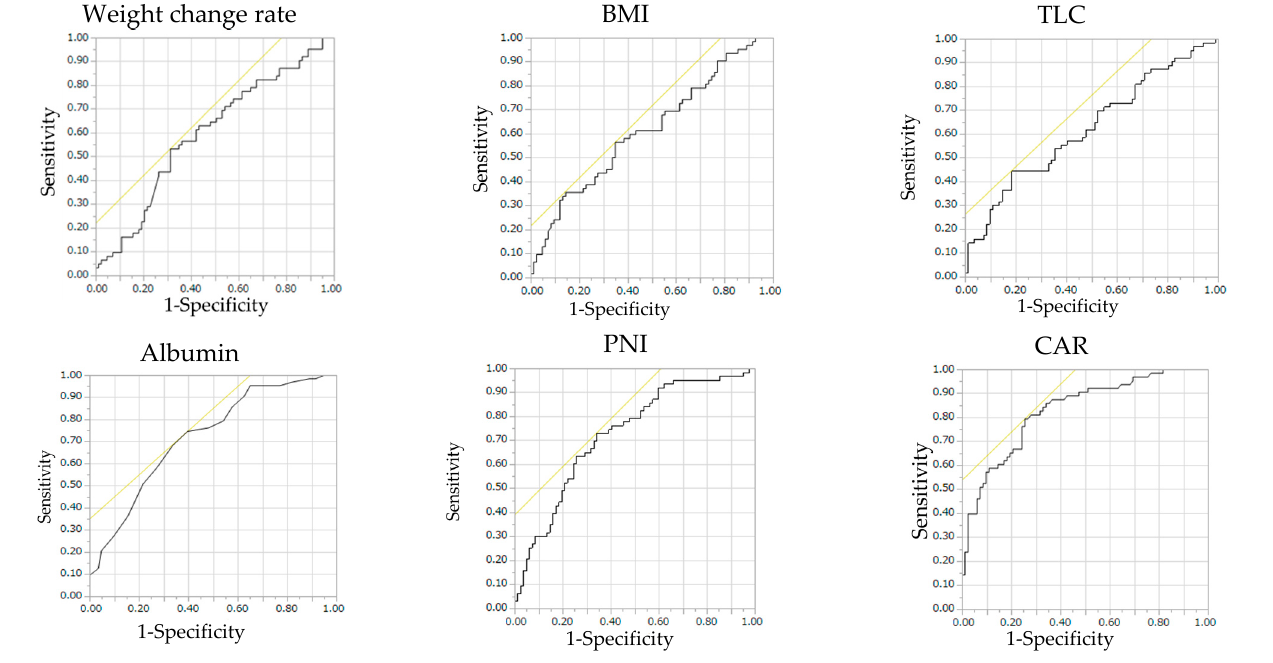
Figure 2. ROC curve of chemotherapy interruption for each nutritional indicator. BMI, body mass index; TLC, total lymphocyte count; PNI, prognostic nutritional index; CAR, C-reactive protein-to- albumin ratio. Sensitivity and specificity for interruption of chemotherapy were calculated using the cut-off values. Table 3. Sensitivity, specificity, AUC, and cut-off values of nutritional indicators for chemotherapy interruption.